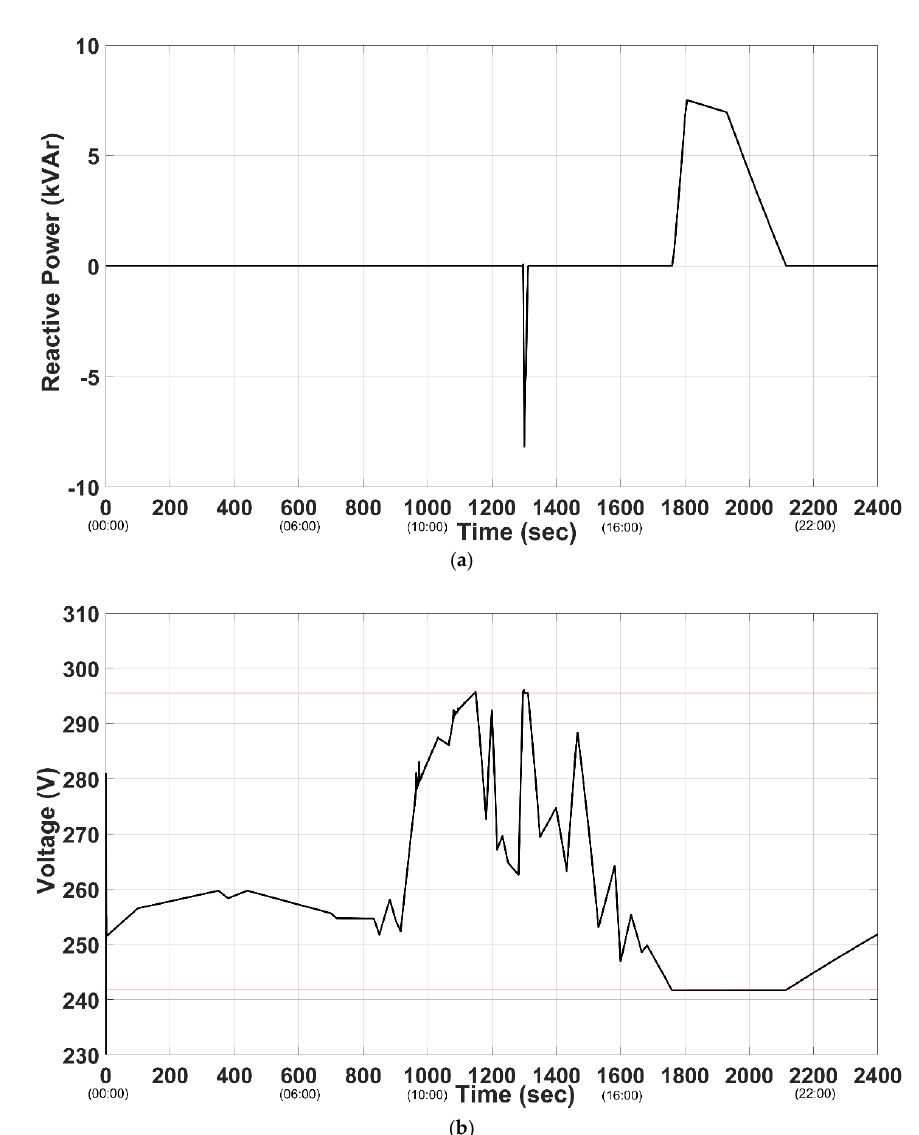
Figure 16. Bus 7: ( a ) the reactive power exchanged with the power grid and ( b ) the voltage power when voltage regulation is activated.